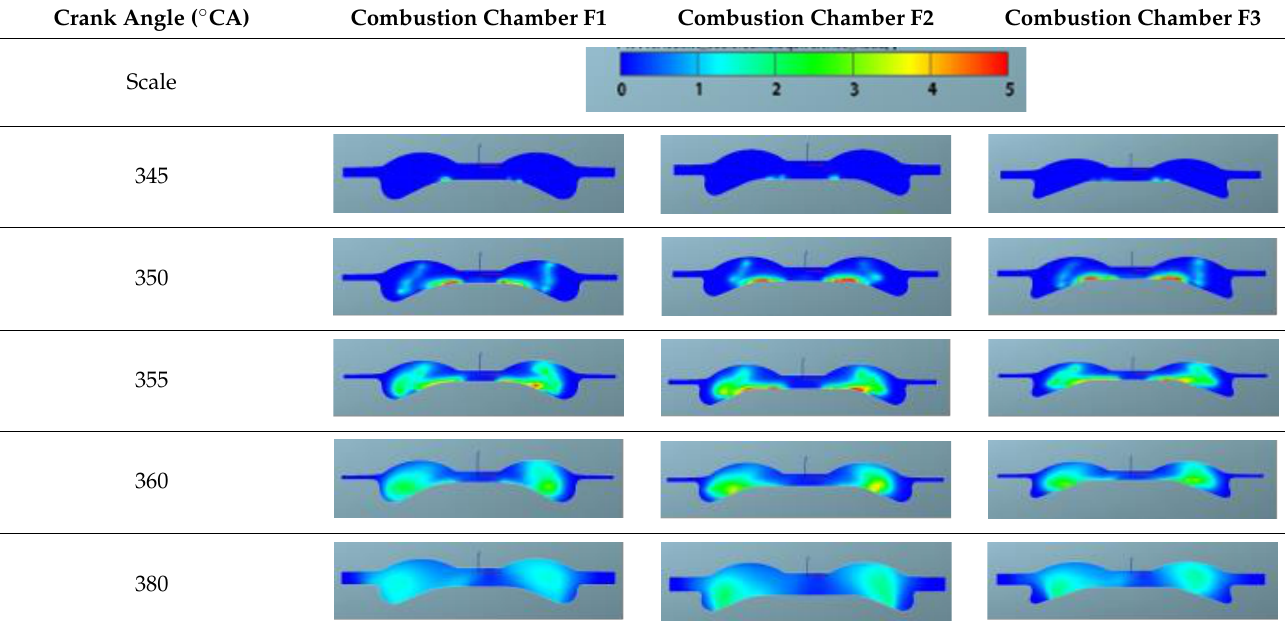
Table 15. Comparison of the fuel–air equivalent ratio of three combustion chamber schemes matched with the 160 ◦ spray angle